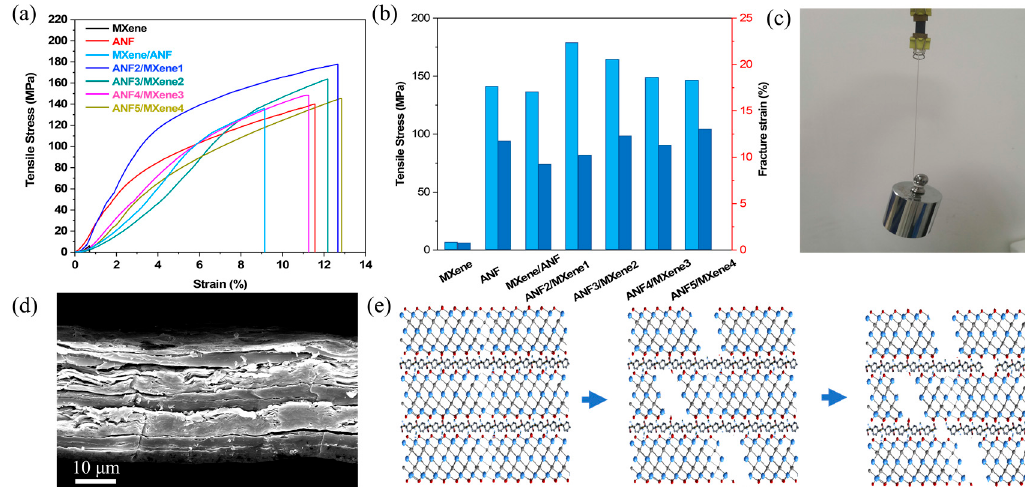
Figure 3. ( a , b ) Tensile-stress curves and statistics of pure ANF, MXene, homogeneous MXene/ANF film and multilayer- structure films; ( c ) digital image of ANF3/MXene2 film stretched by 500 g weight; ( d ) SEM images of cross-sections of ANF3/MXene2 film after tensile fracture; ( e ) Schematic illustrations of the cross-section of the multilayer-structure film after being subjected to mechanical tensile fracture.